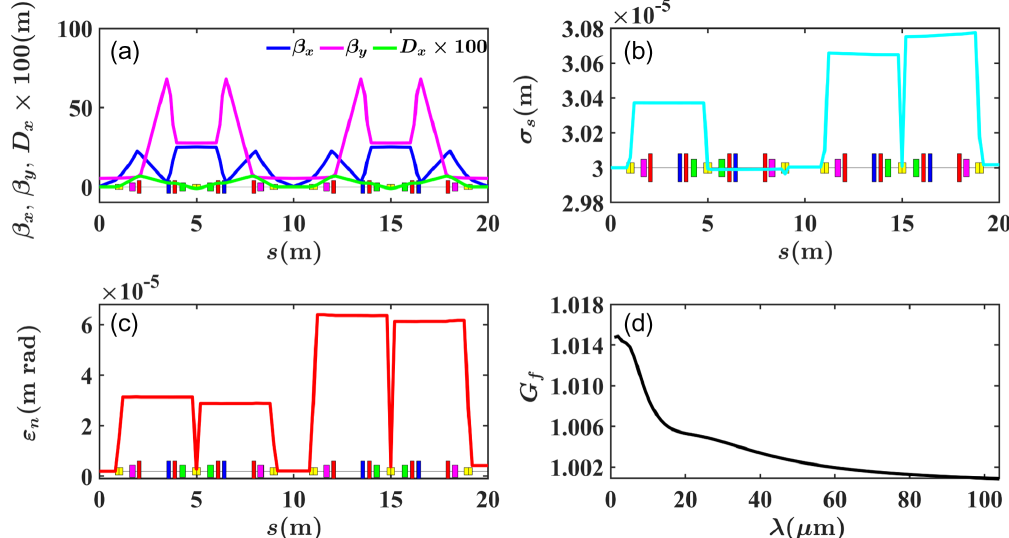
FIG. 10. Simulation results of two TBA cells: (a) optics functions; (b) the bunch length; (c) normalized transverse emittance; (d) the MBI gain.